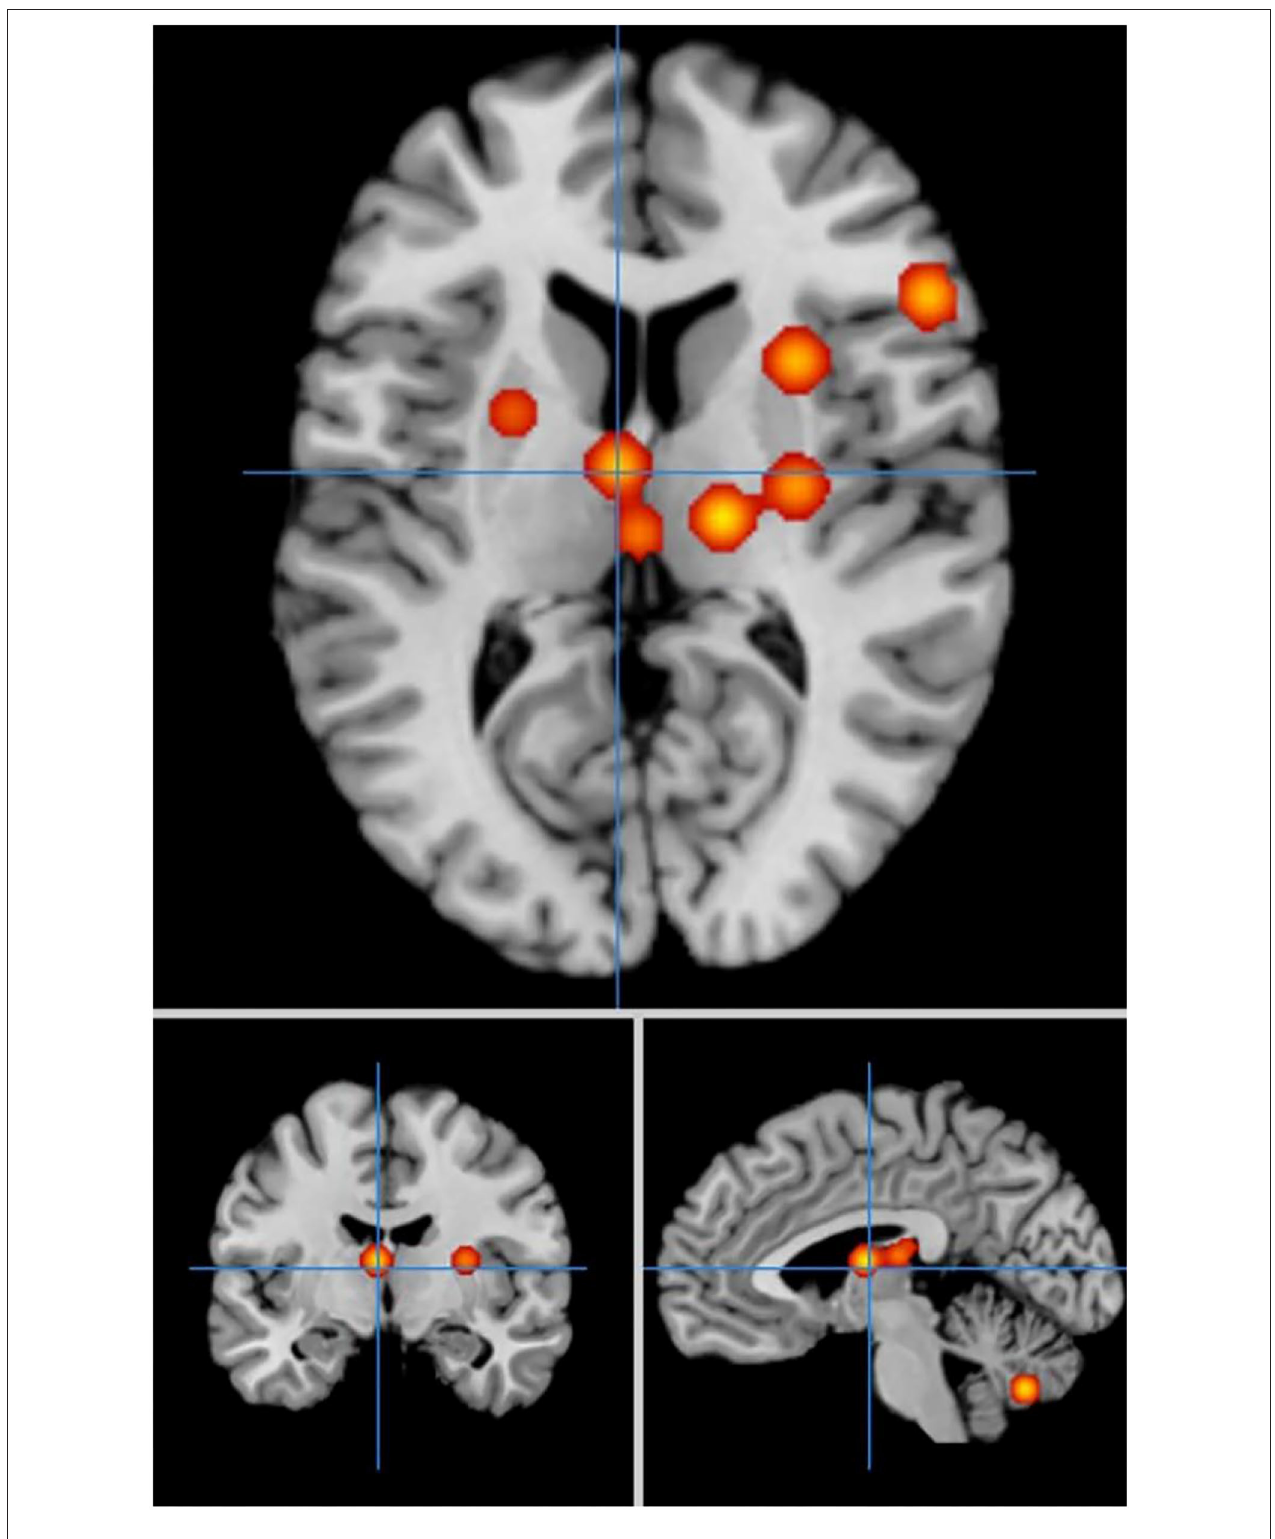
FIGURE 7 | Significant clusters with HC > PD activation in the ALE meta-analysis in cue-priming conditions.